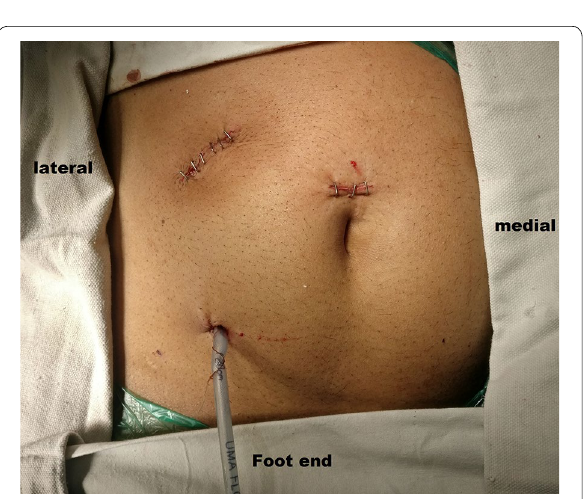
Fig. 7 Post-operative image of the